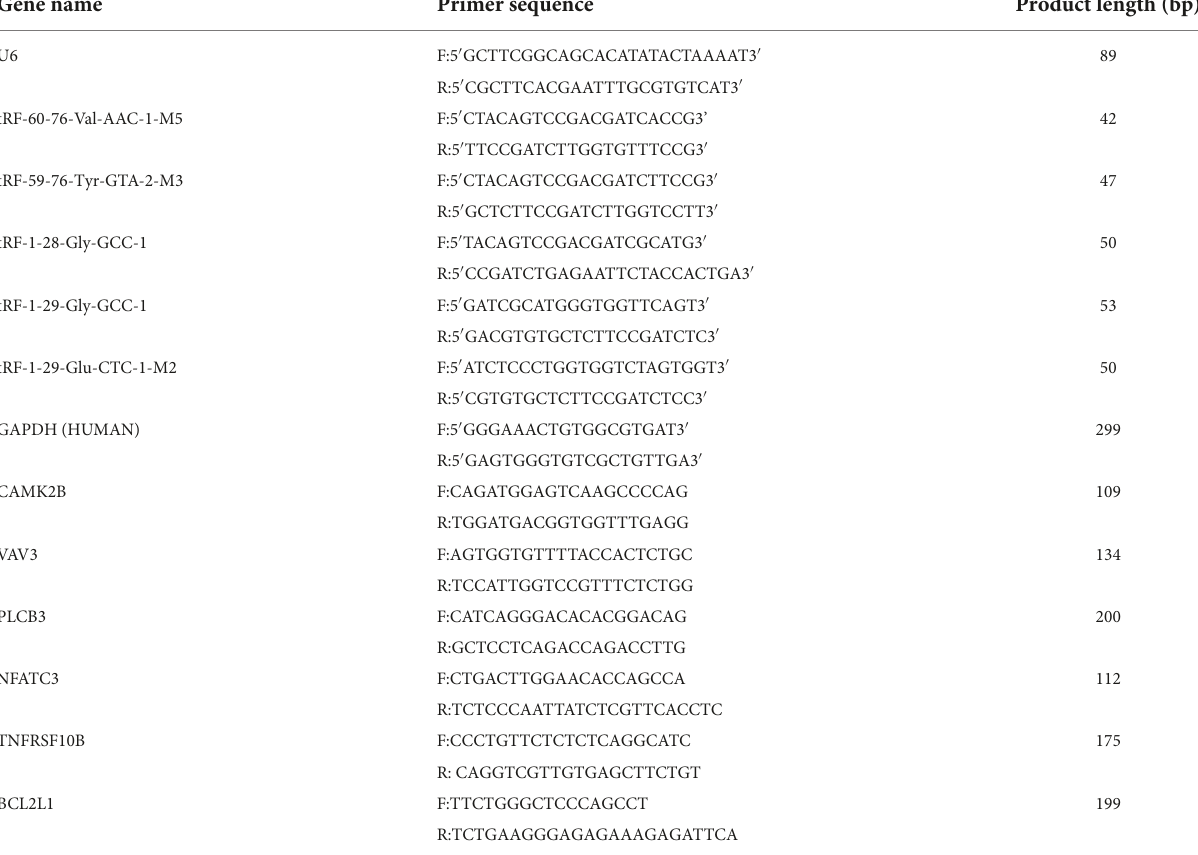
TABLE 1 Specific primers for tsRNA and mRNA in